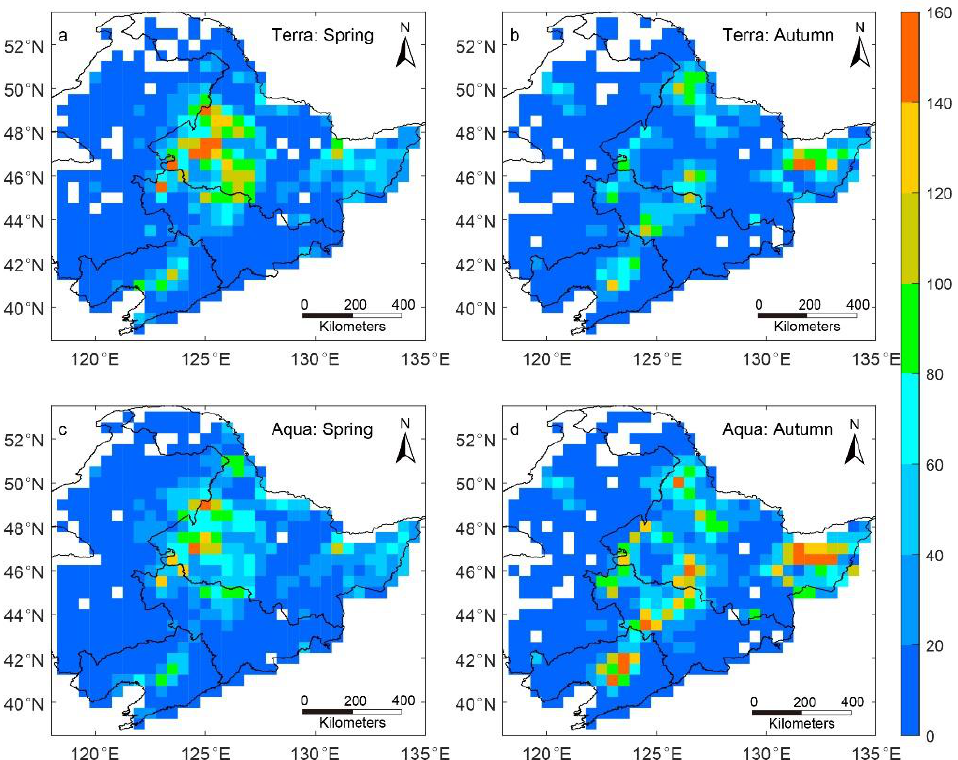
Figure 3. Spatial distribution of the multi-annual average seasonal fire counts in different seasons of ( a , c ) spring and ( b , d ) autumn in northeastern China during 2003–2018 from ( a , b ) Terra and ( c , d ) Aqua fire products, respectively.